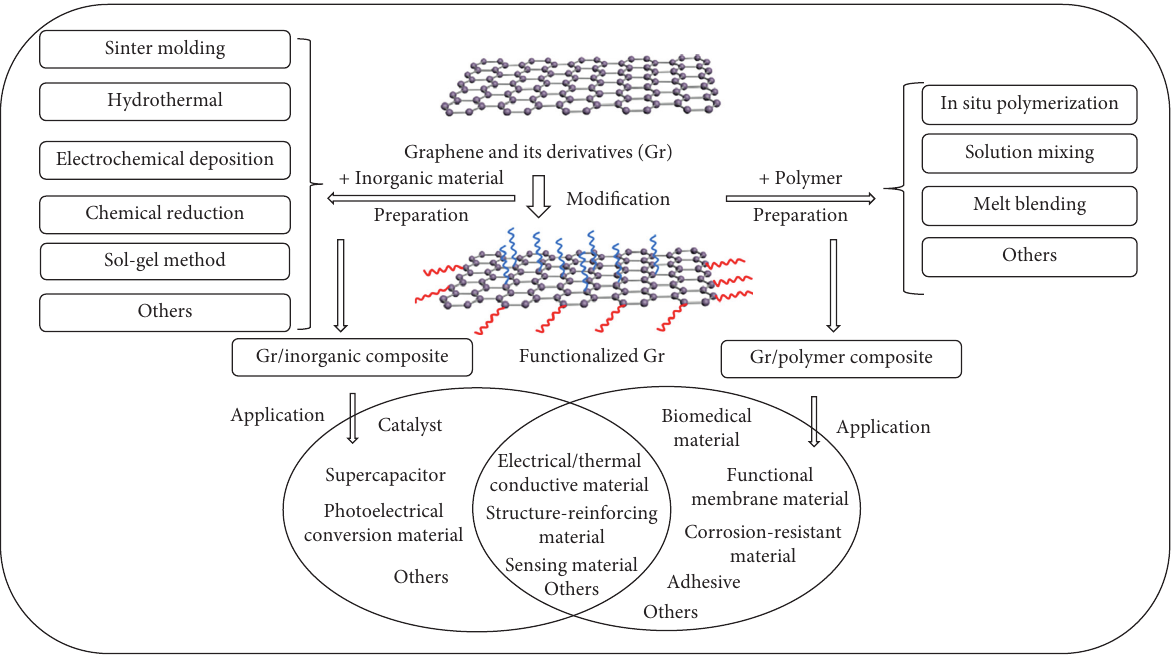
Figure 2: Preparation and application of graphene composite